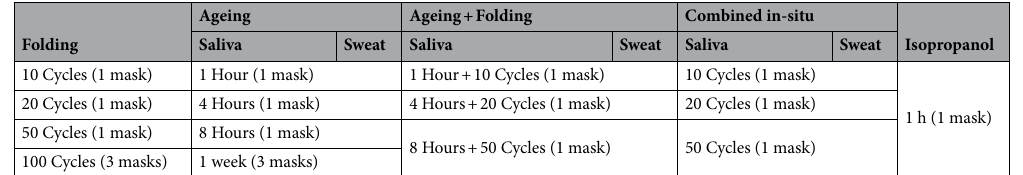
Table 1. List of all the configurations performed during this study classified by type of treatment with the number of masks treated.